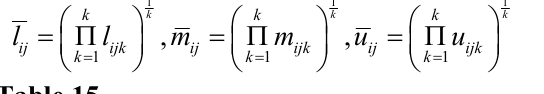
Geometric mean FAHP Criteria